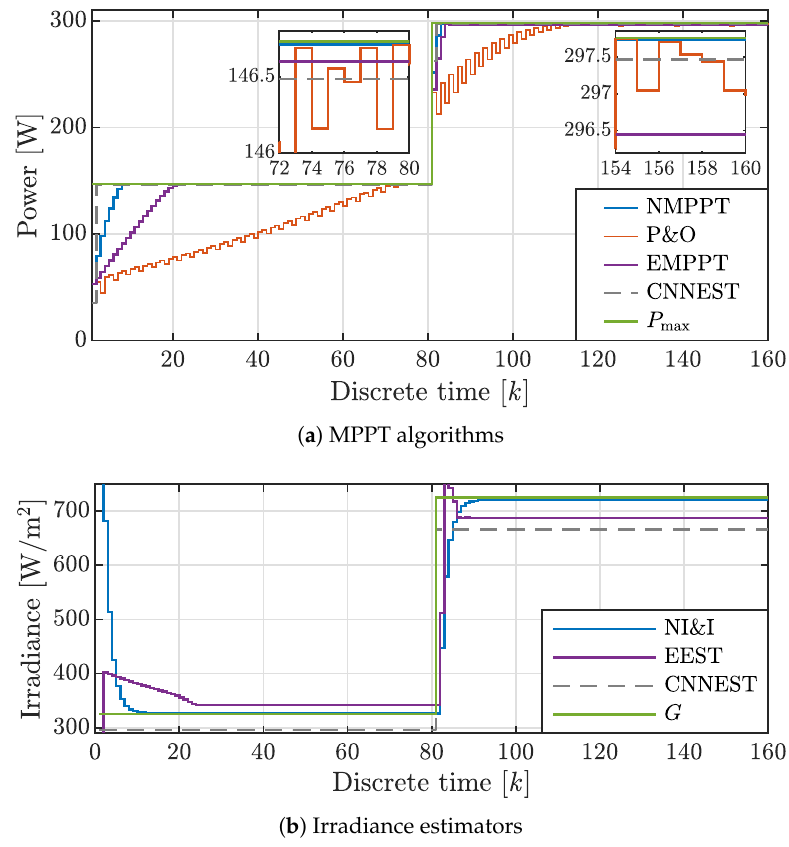
Figure 8. Comparison of the algorithms under sudden change in